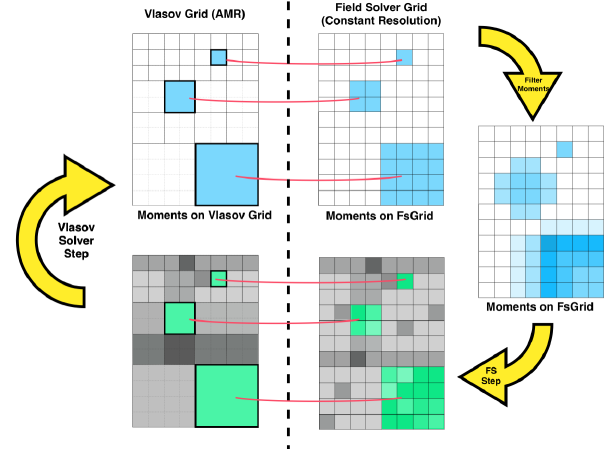
Figure 6. Schematic of Vlasiator’s grid-coupling scheme supple- mented with the extra filtering step to alleviate the staircase effect in 6D AMR runs.